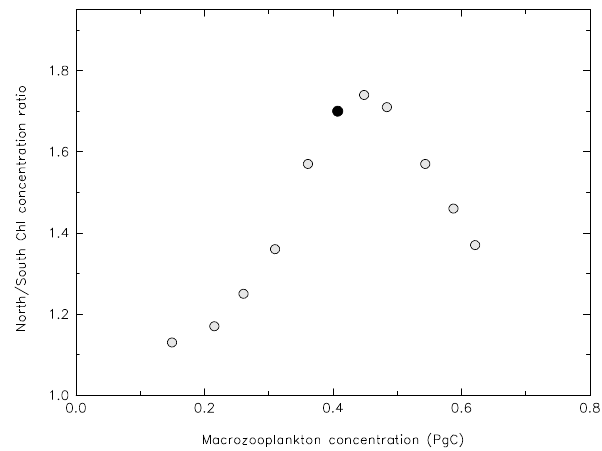
Figure 12. North / south ratio of surface Chl concentration in the Pacific Ocean as in Fig. 9 vs. the surface biomass of macrozoo- plankton (PgCyr − 1 ) . The standard PlankTOM10 results are shown by the filled circle. Results from ten sensitivity tests are shown by the empty circles, where the maximum growth rate of macrozoo- plankton is varied within ± 2 σ within the range of the data (Fig. 2).